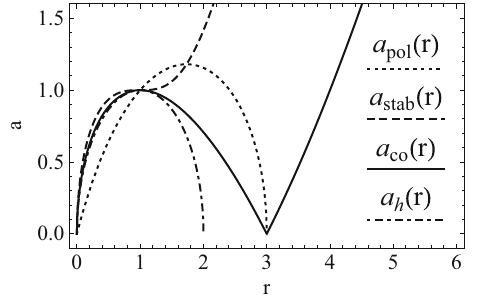
Fig. 1 Characteristic functions a ( r ) determining the behaviour of the function q sph . They govern existence and stability of the SPOs and existence of polar spherical orbits. The event horizons for the black hole spacetimes are given by the function a h ( r ), the function a co ( r ) determines the equatorial circular photon orbits, the function a pol ( r ) determines loci of the polar SPOs with (cid:11) = 0 crossing the rotary axis. The function a stab ( r ) governs the stability of the SPOs – the orbits above/bellow the curve a stab ( r ) are